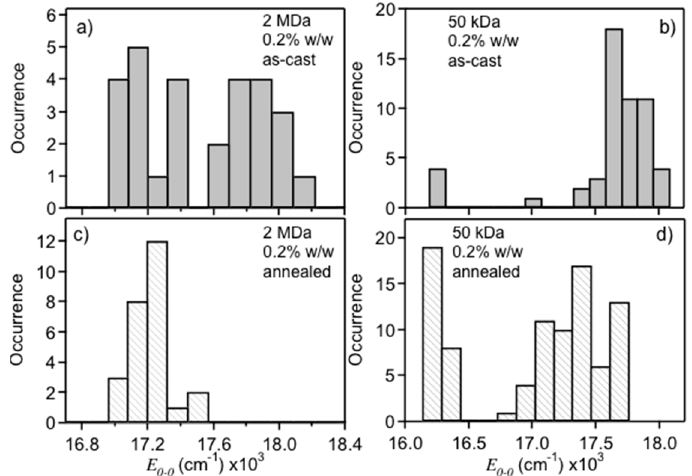
Figure 3. Comparison of PL E 0-0 maxima for MEH-PPV single molecules in dilute: 2 MDa ( a , c ); and 50 kDa ( b , d ) polystyrene dispersions before and after solvent vapor annealing, respectively.